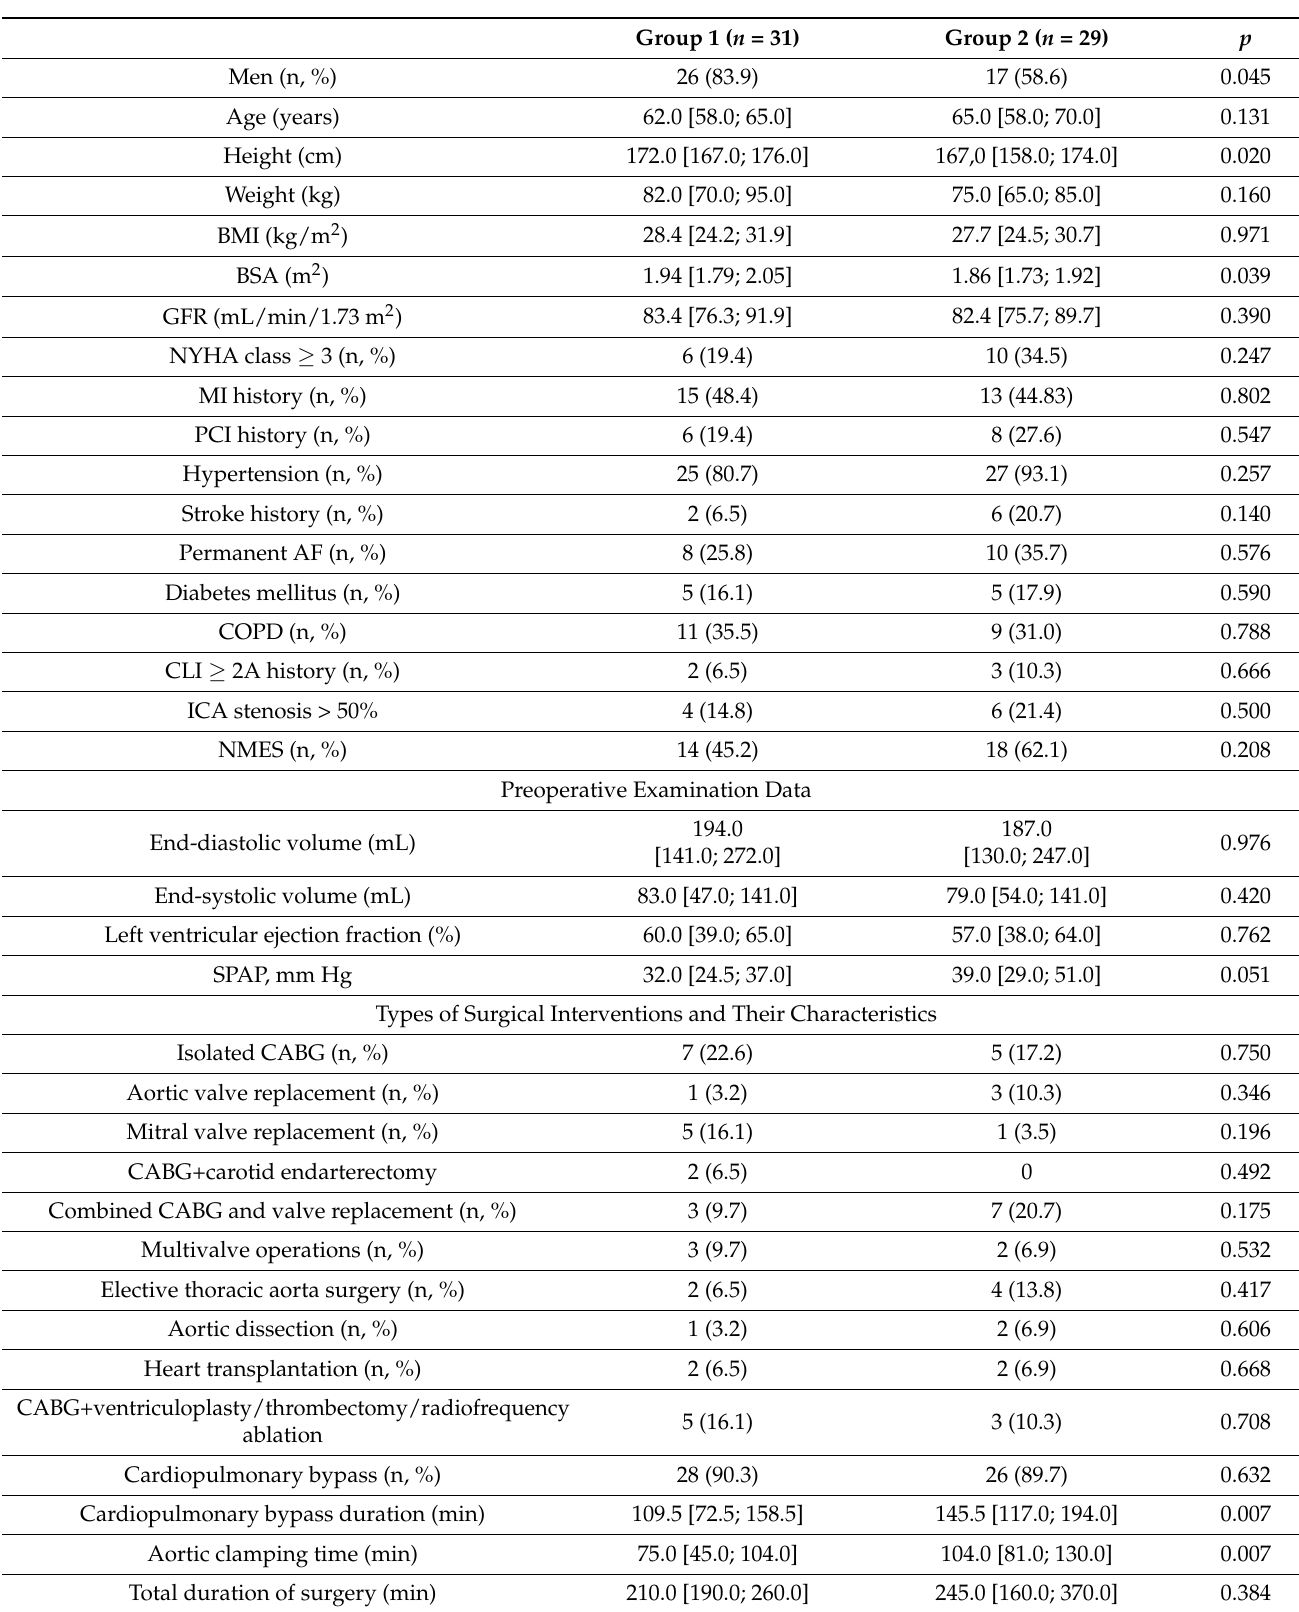
Table 1. Baseline characteristics of patients in